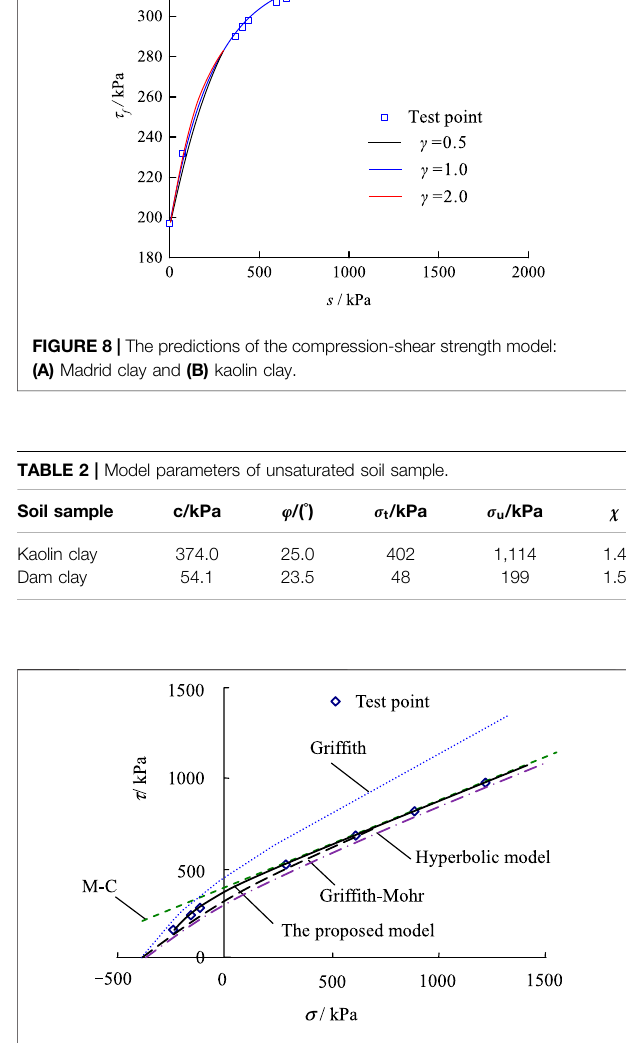
FIGURE 9 | Predictions by different strength models for kaolin clay.